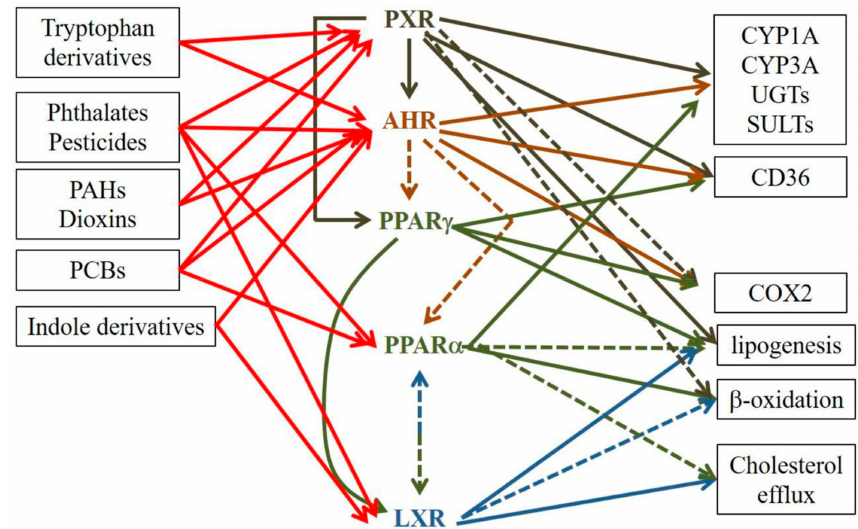
Figure 1. Selected examples of crosstalk between PXR, AHR, PPARs and LXRs. Plain lines designate an activation, whereas dotted lines designate an